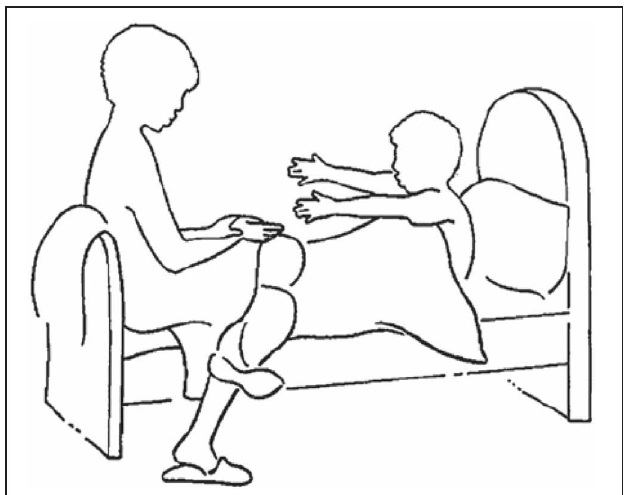
FIGURE A1 | Carol George, Malcolm West, Odette Pettem (1997). Adult Attachment Projective. All rights reserved.